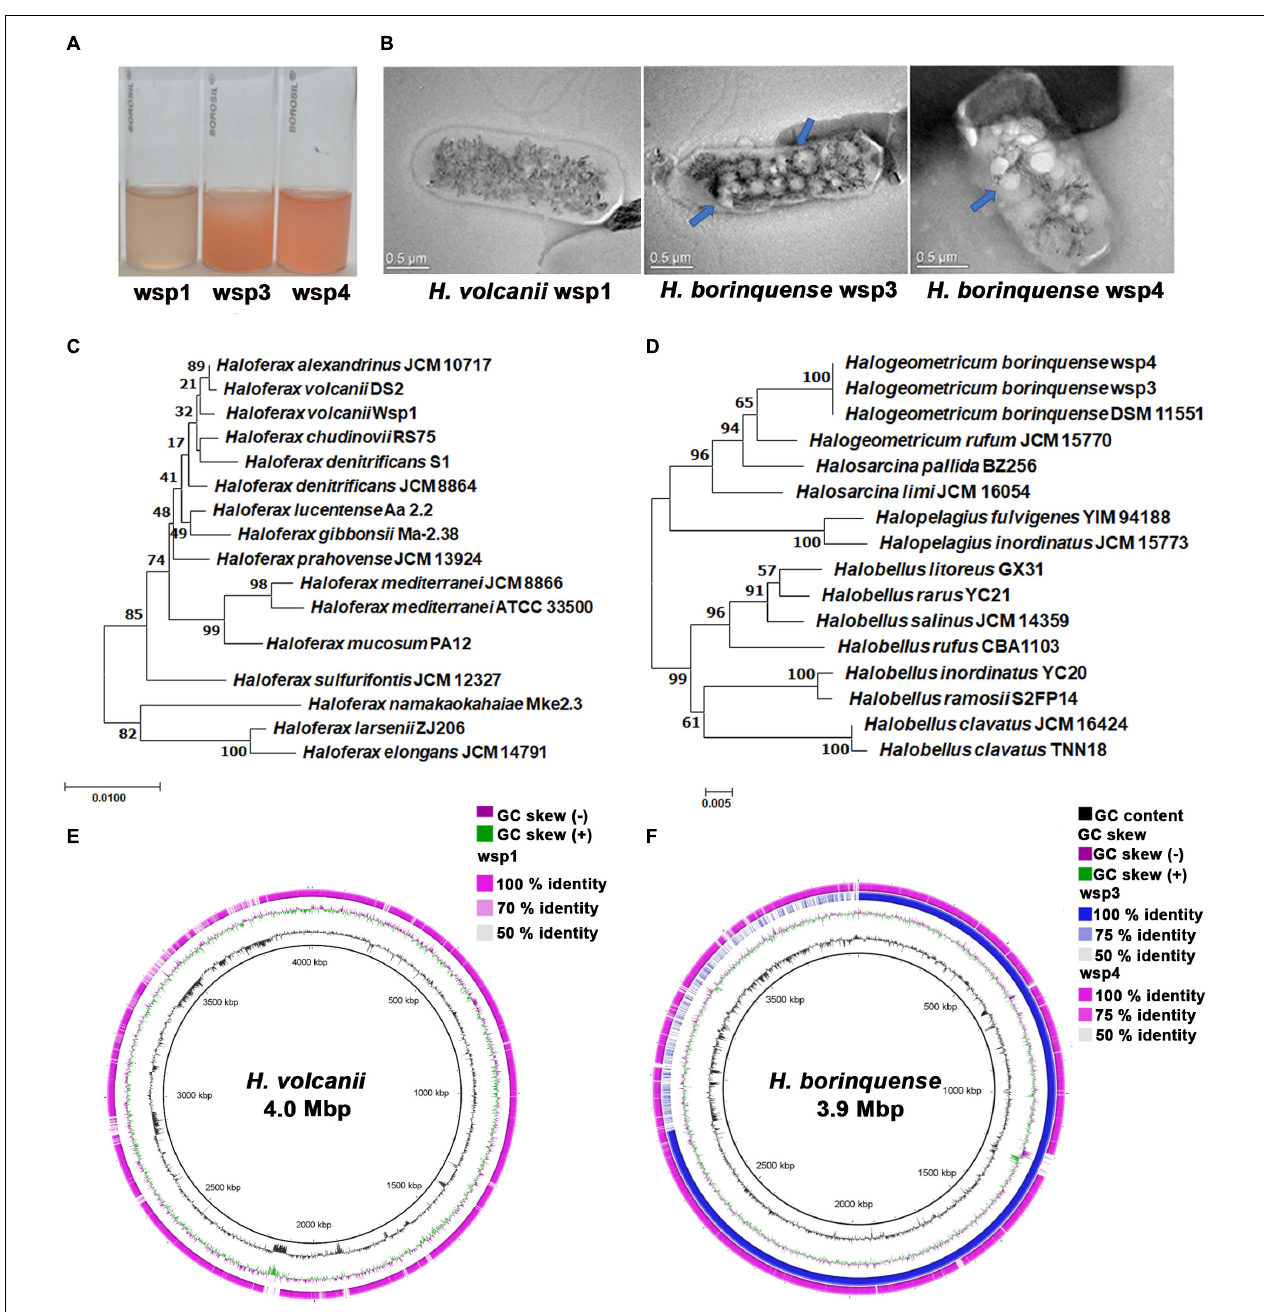
FIGURE 1 | Morphological and taxonomic characterization of the haloarchaeal isolates. (A) Wild type culture of haloarchaeal isolates in light reddish-pink color suggesting high carotenoid production. (B) TEM images suggest that wsp3 and wsp4 are highly vacuolated (shown in blue arrow) compared with wsp1 (C,D) The16S rRNA based phylogenetic analysis suggested that wsp1 strain is closely related to H. volcanii DS2 while both wsp3 and wsp4 are closely related to H. borinquense DSM 11551. (E,F) Genomic maps of the isolates and their reference species constructed using the BRIG tool. The inner black rings show the coordinates in scale and total genome size of the reference sequence, with black histogram representing GC content and purple/green histograms representing GC deviations. In the panel, (E) outermost ring in magenta color represents the genome map of wsp1 strain and in the panel, (F) blue color represents wsp3 genome map while wsp4 genome map is represented in magenta